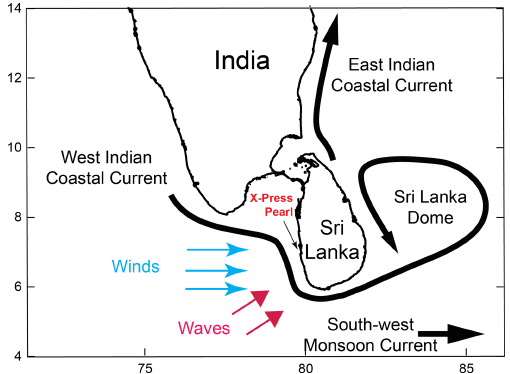
Figure 7. Location of the X-Press Pearl and the major currents in the region. The wind and wave directions experienced during the incident are also shown.